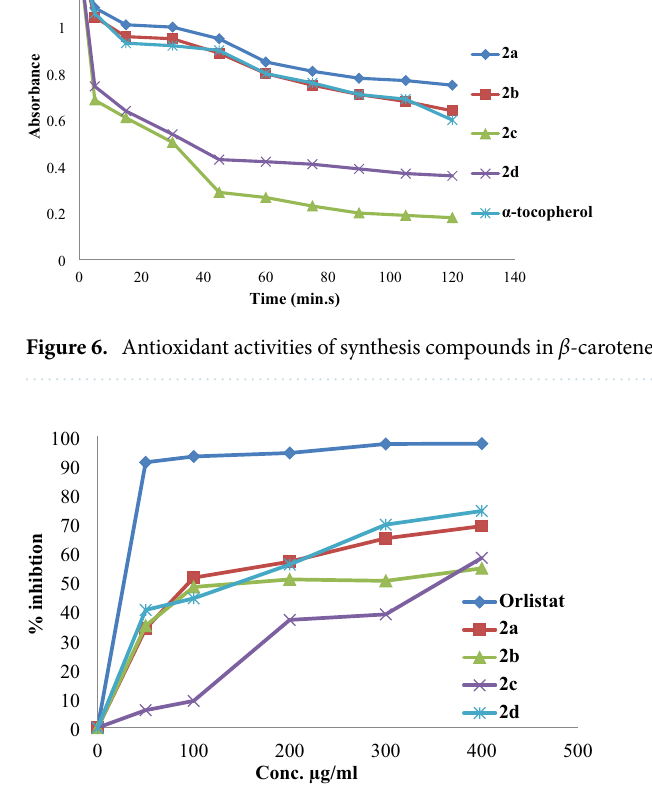
Figure 7. Lipase inhibition % by the synthesized compounds and